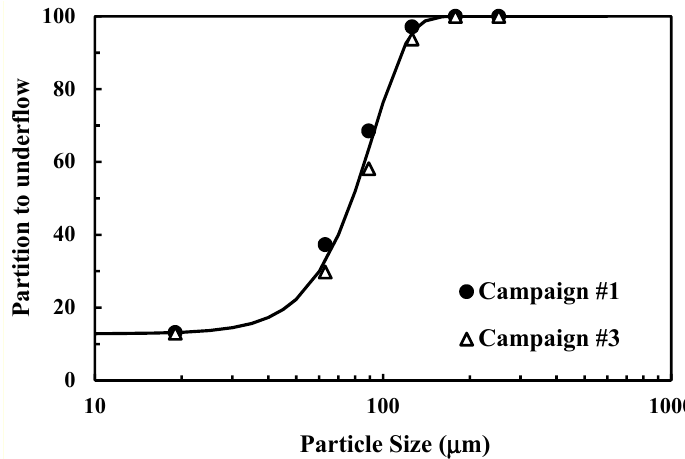
Figure 16. Partition curve of the hydrocyclones, from two surveys in which the flows properly mass balanced.